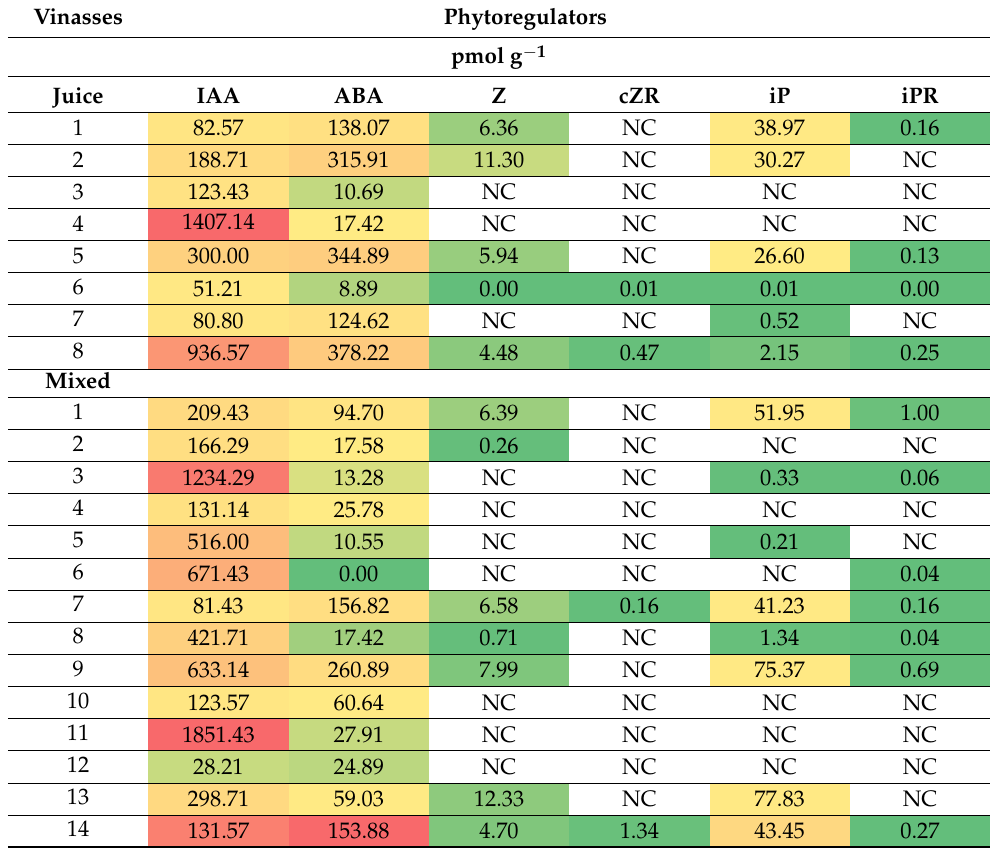
Table 1. Concentration of some phytoregulators in diverse types of cane vinasse. Zeatin (Z), cis-zeatin riboside (c-ZR), isopentenyladenine (iP), isopentenyladenosine (iPR), indole-3-acetic acid (IAA), and abscisic acid (ABA). (Red—higher concentrations; yellow/green—lower